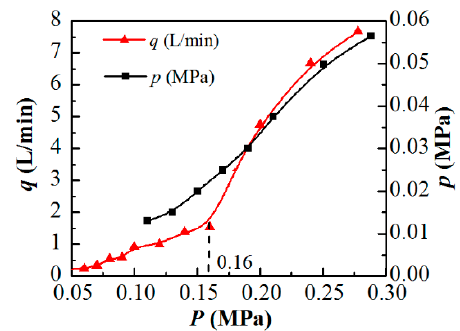
Figure 4. Suction capacity ( q ) and negative pressure ( p ) as functions of feeding pressure ( P ) in double cosine self-aspirated nozzle.